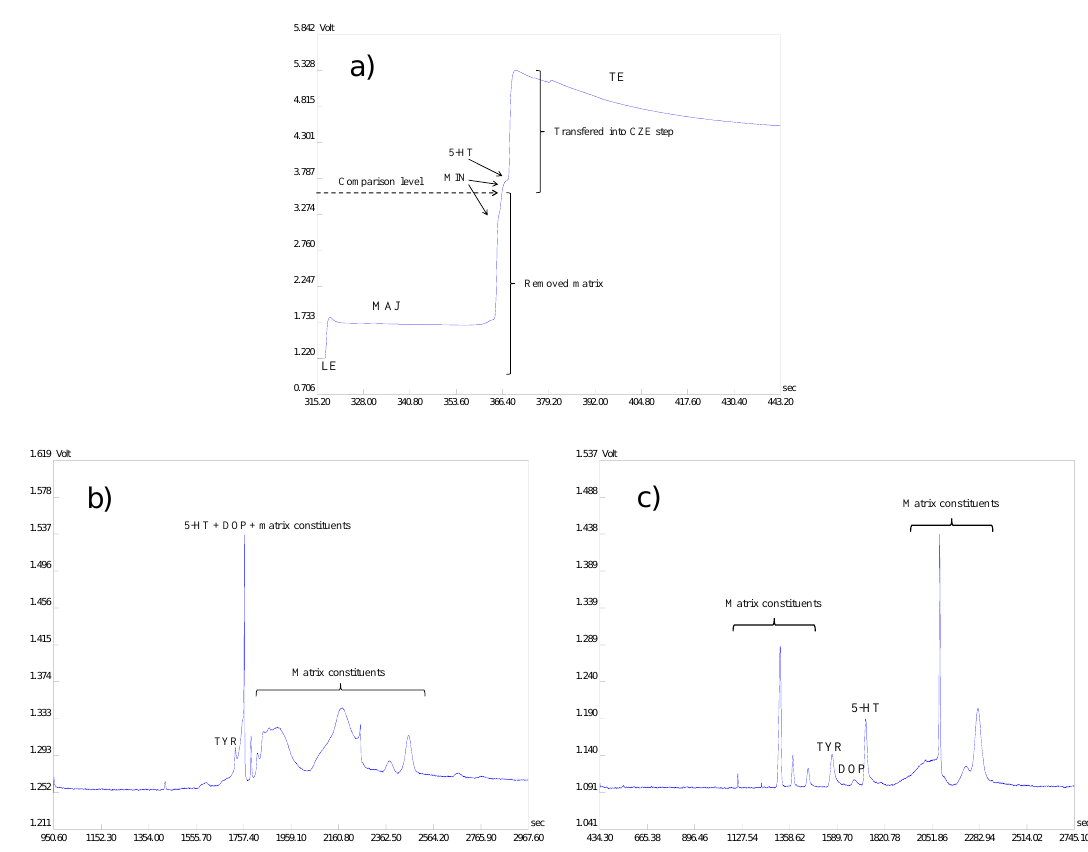
Figure 1. Isotachophoresis–capillary zone electrophoresis–ultraviolet (ITP–CZE–UV) analysis of model urine samples spiked with three biogenic amines—5-hydroxytryptamine (5-HT), dopamine (DOP), and tyramine (TYR). ( a ) Optimized ITP profile. ( b ) CZE profile without additives influencing separation of the analytes, background electrolyte (BGE): 25 mM ε -aminocaproic acid (EACA) + 50 mM acetic acid (HAc) + 0.1% m-HEC. ( c ) Optimized CZE profile with additives influencing separation. The human urine samples were diluted 10 times. The biogenic amines were present at 50 ng · mL − 1 concentration levels of their hydrochloride salts (41.43 ng · mL − 1 of 5-HT, 40.39 ng · mL − 1 of DOP and 39 · 50 ng · mL − 1 of TYR base). For other instrumental parameters and optimum ITP and CZE separation conditions see the Sections 2.1 and 3.1. LE—leading electrolyte, MAJ—major sample matrix constituents, MIN—minor sample matrix constituents, TE—terminating electrolyte.